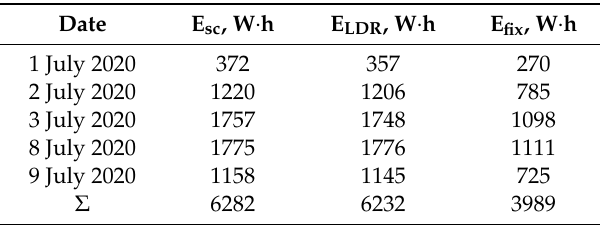
Table 2. Total amount of power generated by day.